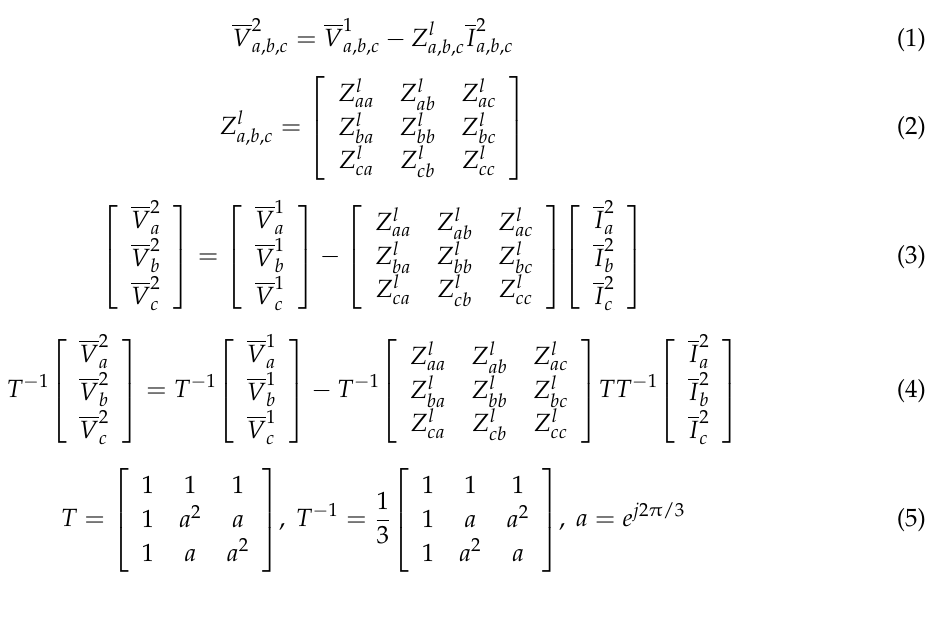
Figure 2. Equivalent circuit model between two buses.